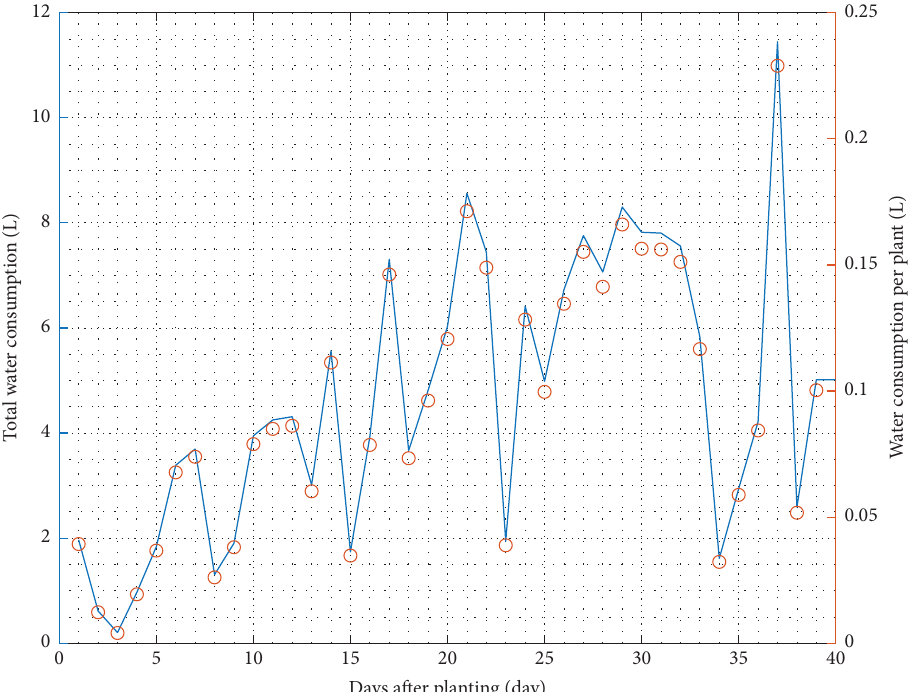
Figure 6: Water consumption during mustard pagoda